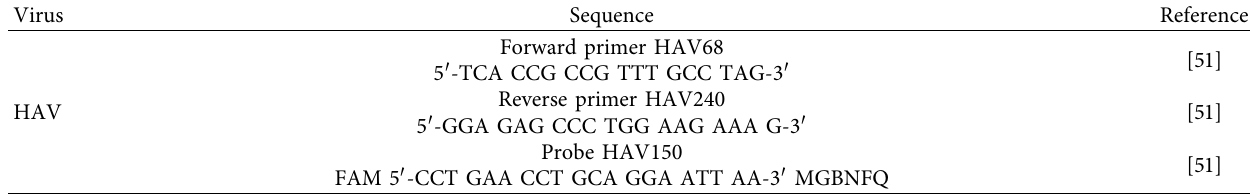
Table 1: Sequences of the primers and probe used for HAV detection. Virus